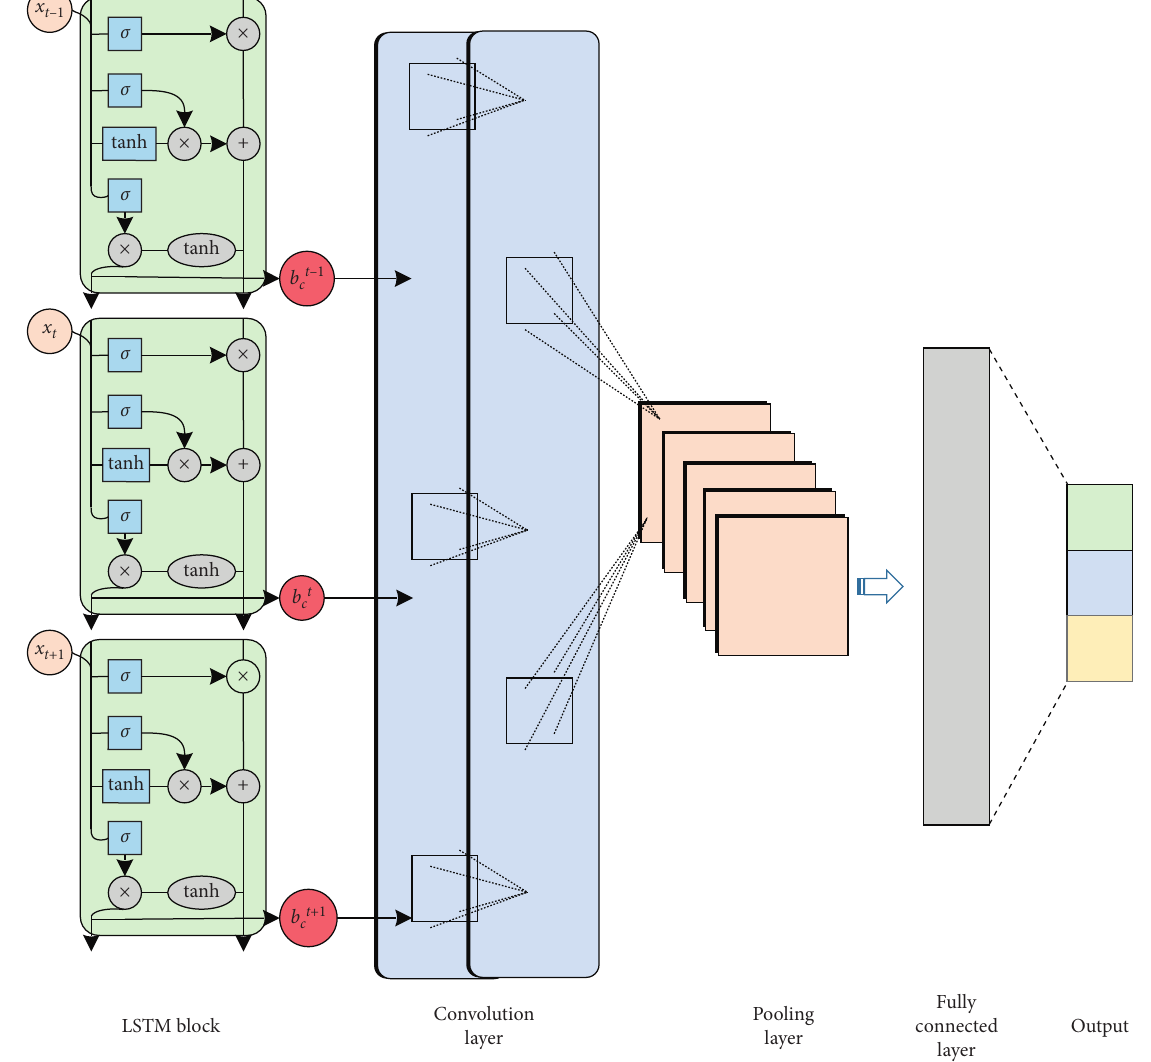
Figure 4: Long short-term memory and convolutional neural network